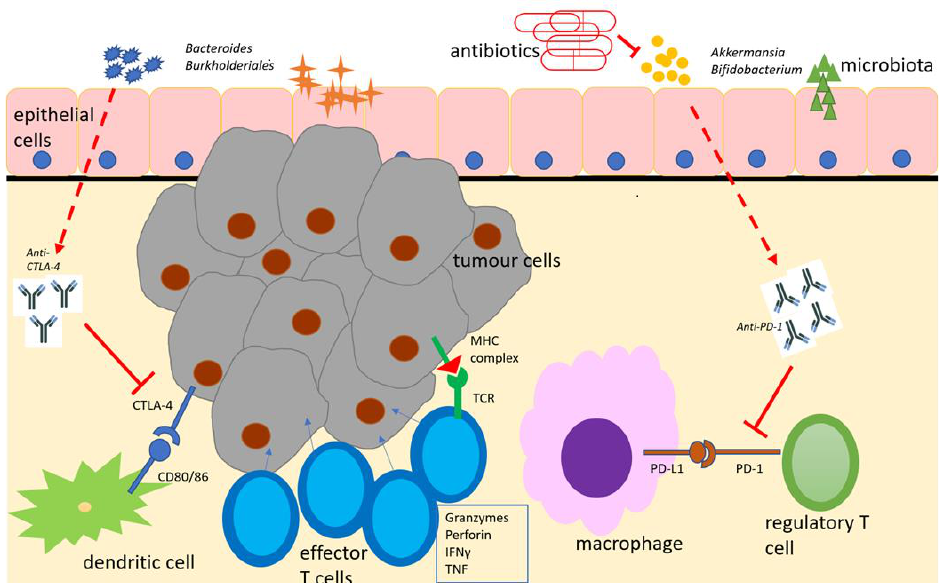
Figure 1. Schematic representation of the microbiome with immunotherapeutic agents (anti-PD-1 and anti-CTLA-4), antigen-presenting cells and effector cells in the tumour immune microenvironment. Adapted from [70]. Beneficial microbiota boost the effects of immune checkpoint inhibitors, which, in turn, suppress regulatory T-cell responses and enhance effector T-cell responses to encourage tumour cell lysis. Antimicrobial therapy suppresses beneficial microbiota and diminishes this response. CTLA-4 = cytotoxic T-lymphocyte antigen- 4. IFNγ = interfe ron gamma. MHC = major histocompatibility complex. PD-1 = programmed cell death -1. PD-L1 = programmed cell death ligand 1. TCR = T-cell receptor.